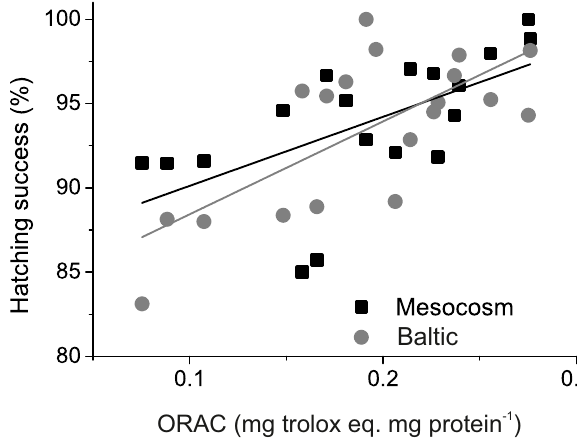
Figure 3. Correlations of copepod EH with maternal